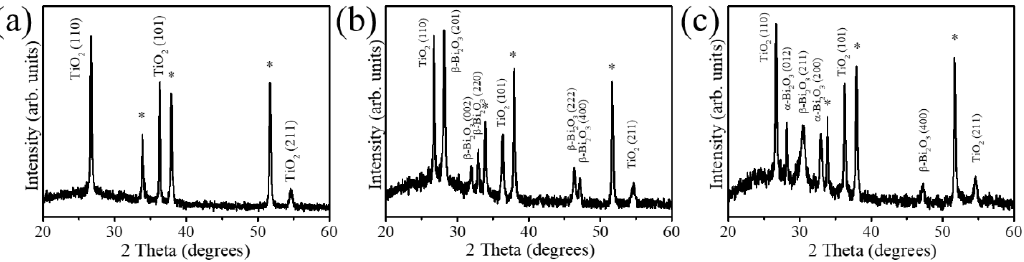
Figure 2. X-ray di ff raction (XRD) patterns: ( a ) rutile TiO 2 rods. ( b ) TiO 2 / s–Bi 2 O 3 rods, ( c ) TiO 2 / a–Bi 2 O 3 Figure 2. X-ray diffraction (XRD) patterns: ( a ) rutile TiO 2 rods. ( b ) TiO 2 /s – Bi 2 O 3 rods, ( c ) TiO 2 /a – Bi 2 O 3 rods. The asterisks denoted Bragg reflections from the F-doped SnO 2 (FTO) rods. The asterisks denoted Bragg reflections from the F-doped SnO 2 (FTO) substrate.